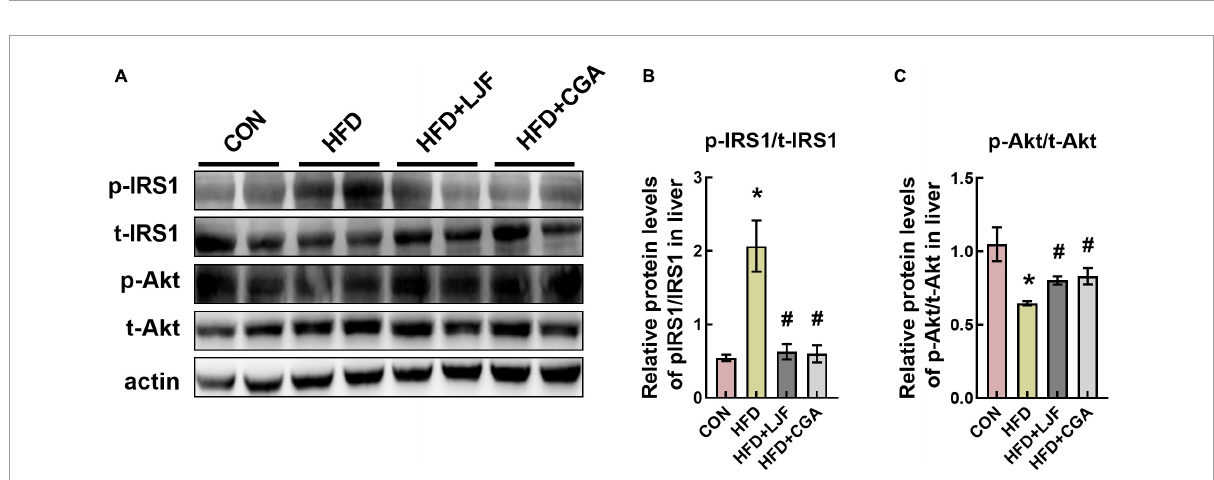
FIGURE4 Lonicerae Japonicae Flos and CGA improved the insulin signaling pathway in rat liver. (A–C) Protein levels and densitometric quantification of phospho-insulin receptor substrate 1 (p-IRS1) (Ser307), total(t)-IRS1, phospho-protein kinase B (p-Akt) (Ser473), total(t)-Akt, and β -actin, bars represent densitometric quantification normalized to β -actin. All bars show means ± SEM. ( n = 4 per group). * P < 0.05, vs. CON group; # P < 0.05, vs. HFD